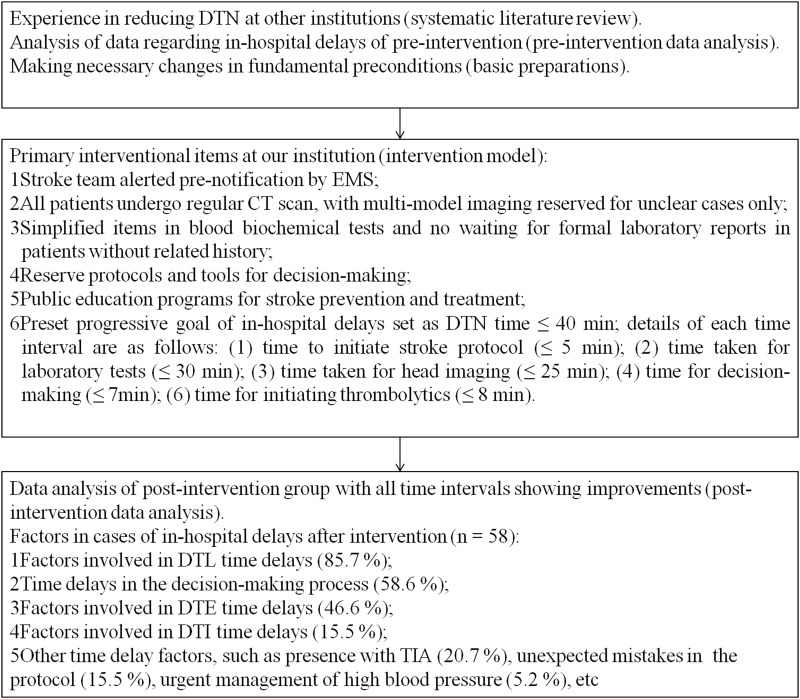
Flow chart of the GRASPs study for reducing in-hospital delays.